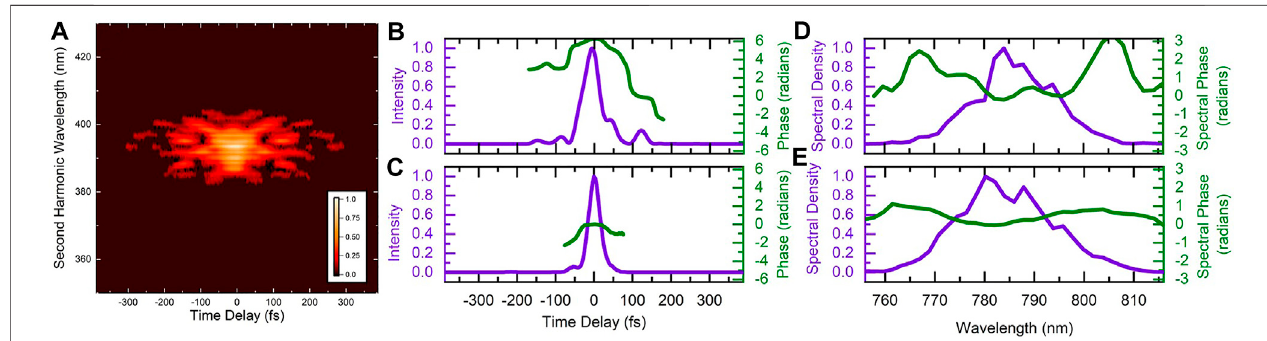
FIGURE3|(A) Measuredfrequency-resolved-optical-gratingtraceofthelaserpulseoptimizedtoincreasetheD 2 H + :D + 3 ratio. (B) Theretrievedintensity(violet)and temporal phase (green) of the optimized pulse. While second-harmonic-generation is symmetric with respect to time, this ambiguity can be removed with the additional information from the pulse shape parameters. (C) The retrieved intensity and temporal phase of an unshaped laser pulse for comparison, using the same color scheme. (D) The retrieved spectral density (violet) and phase (green) of the optimized pulse. (E) The unshaped spectral density and phase for comparison, again with the same color